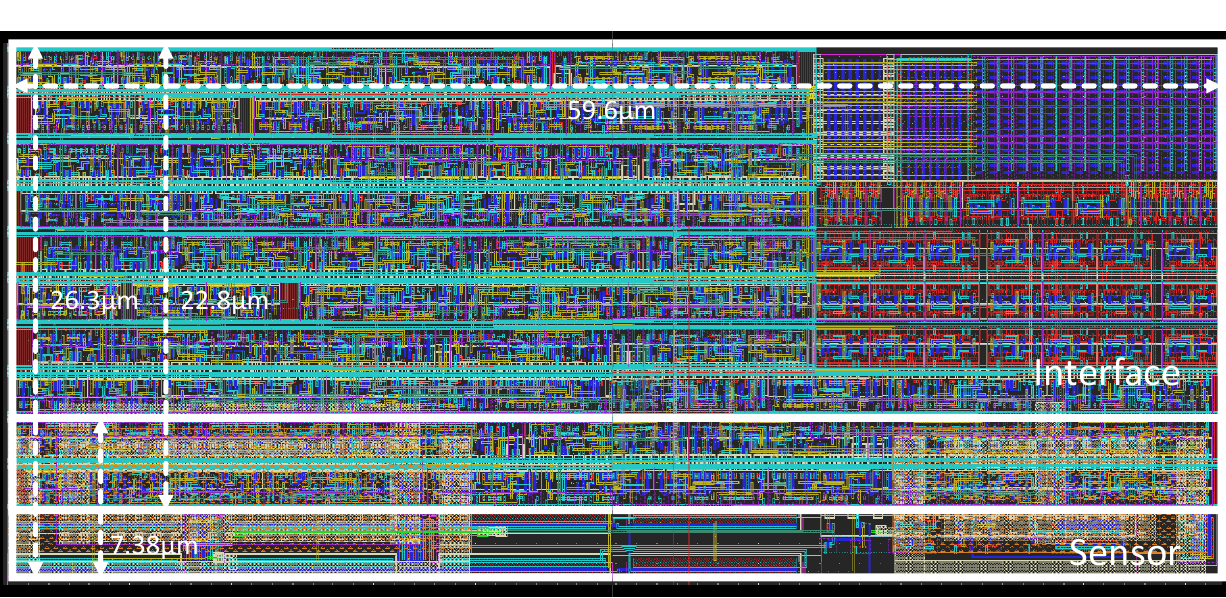
Figure 6. Layout of the 65 nm temperature sensor.